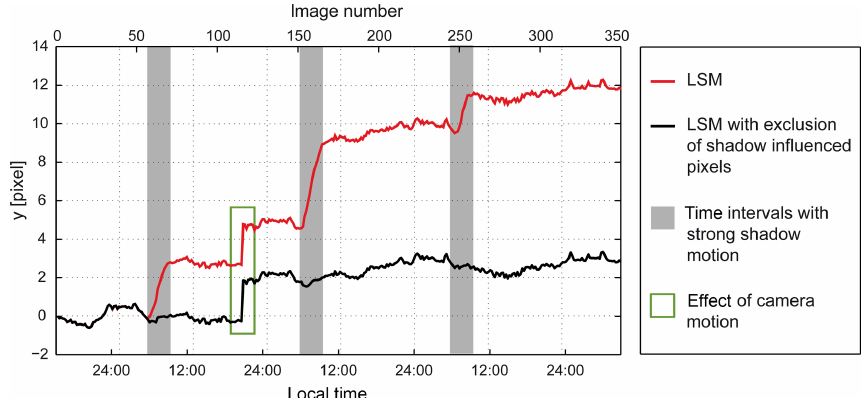
Figure 8. Drift effects during the measurement of a trajectory due to shadow movement. The figure shows the vertical component of a glacier trajectory measured using least squares matching (LSM) with and without shadow pixel exclusion. At certain times of the day (grey background), particularly strong shadows occur. Both motion curves still contain the influence of the camera motion.